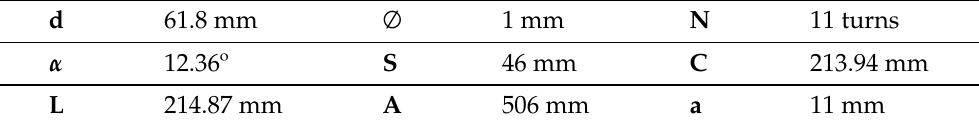
Table 3. Design parameters of the antenna.